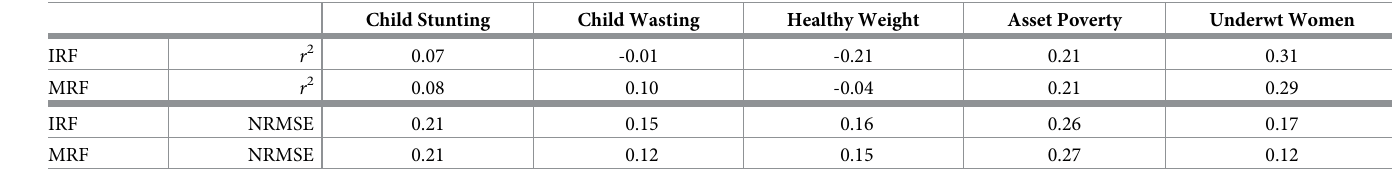
Scores are computed by pooling all predictions across all surveys, with shared testing and training folds used across all